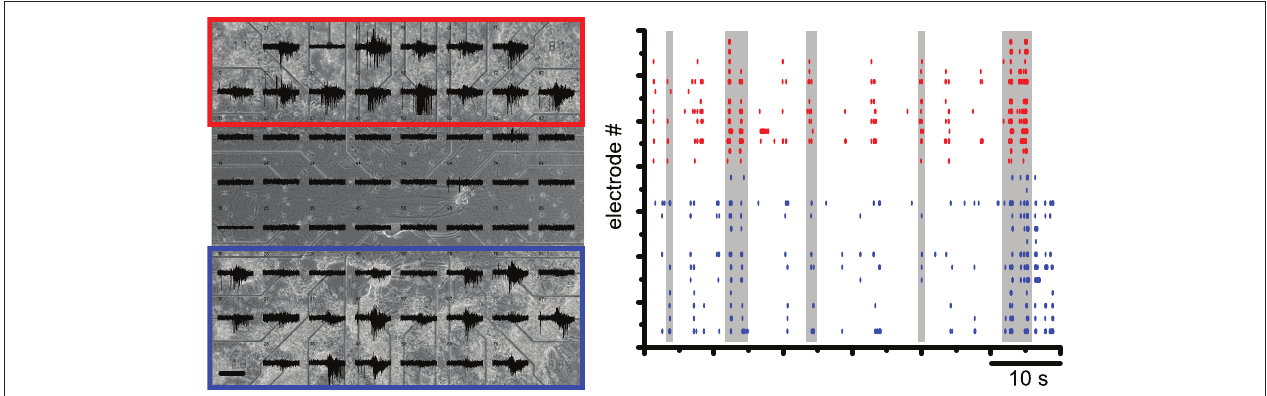
representing the activity recorded by the cortical electrodes (red) and the striatal electrodes (blue). The overall activity of the network seems to be defined by synchronous firing of the cortical neurons. Gray stripes indicate the entrainment of firing in the striatal compartment in time with the cortical